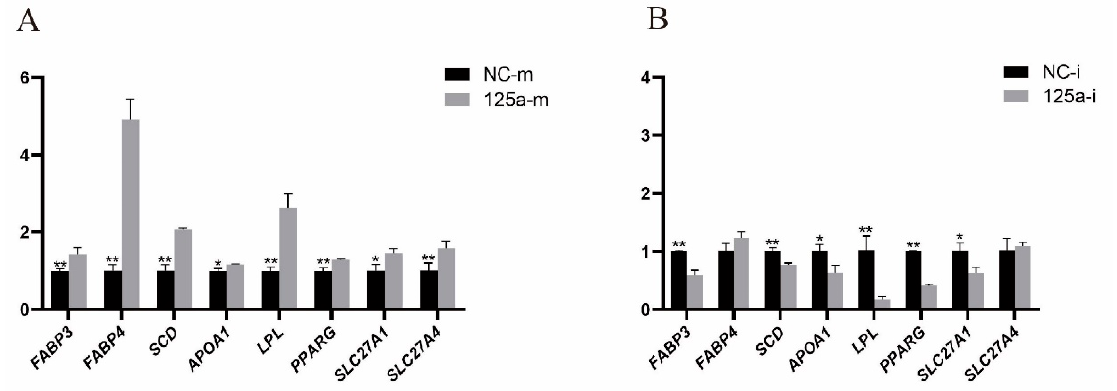
Figure 5. ( A ) Expression of lipid-related genes after miR-125a-mimic transfection; ( B ) Expression of lipid-related genes after miR-125a-inhibitor transfection. * Significant difference between the control and the treatment ( p < 0.05); ** Very significant difference between the control and the treatment ( p < 0.01).